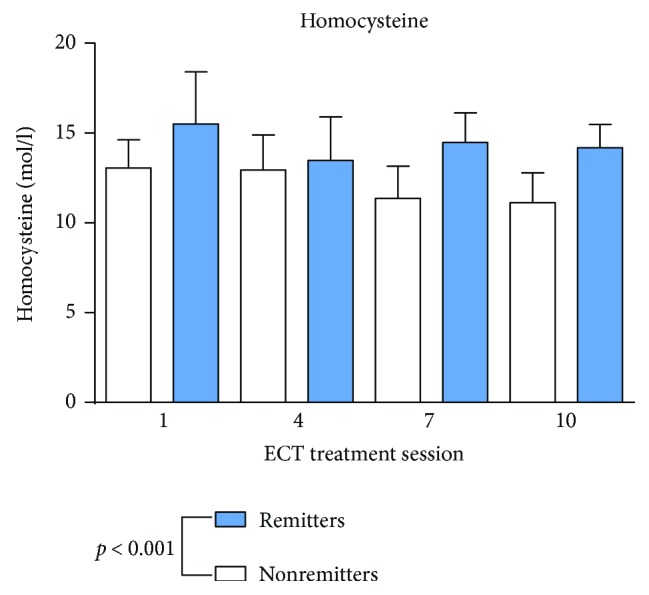
Homocysteine serum levels in remitters and nonremitters. Mixed linear modelling showed significantly higher serum levels in homocysteine in remitted patients. The p value given in the figure is derived from mixed linear modelling. Error bars show the standard error of the mean (SEM).